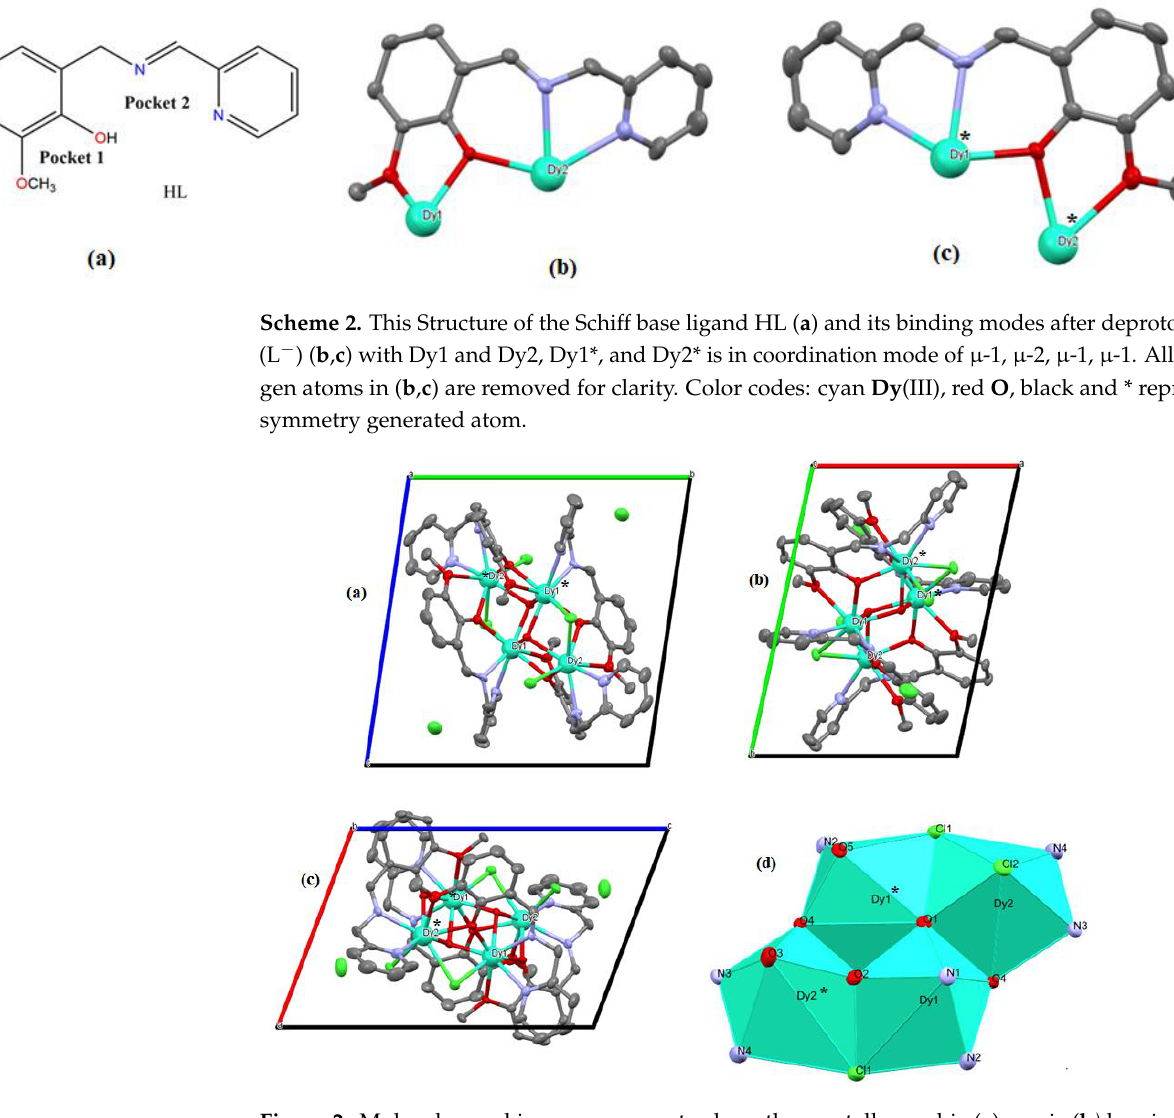
Figure 2. Molecular packing arrangements along the crystallographic ( a ) a-axis ( b ) b-axis and ( c ) c-axis ( d ) Coordination polyhedra of distorted biaugmented trigonal prism (BTP) geometry observed for Dy(III) ion in complex 1 . All hydrogen atoms are omitted for clarity. Color codes: cyan Dy (III), red O , black, C and green Cl .